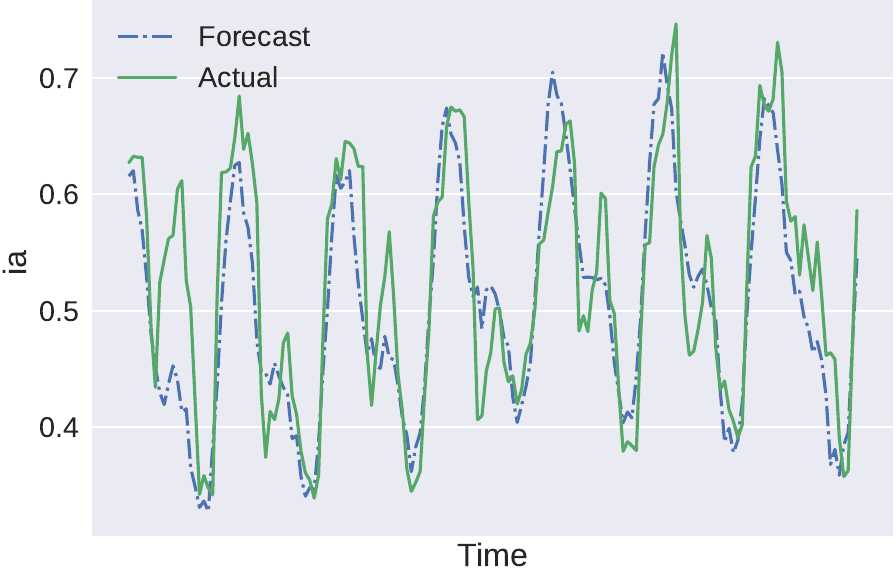
Figure 17. Forecast plot for SMAPE <